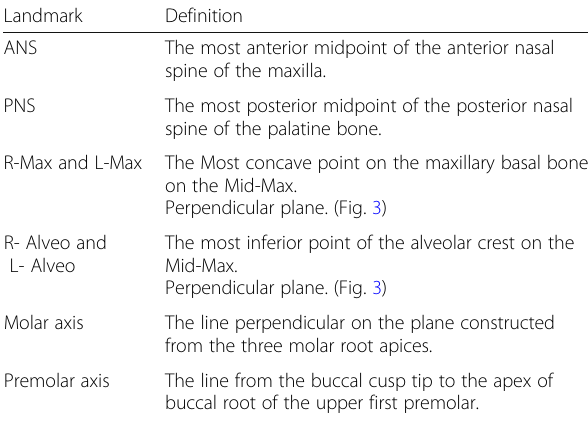
Table 2 Landmark definition for structures affected by treatment Landmark